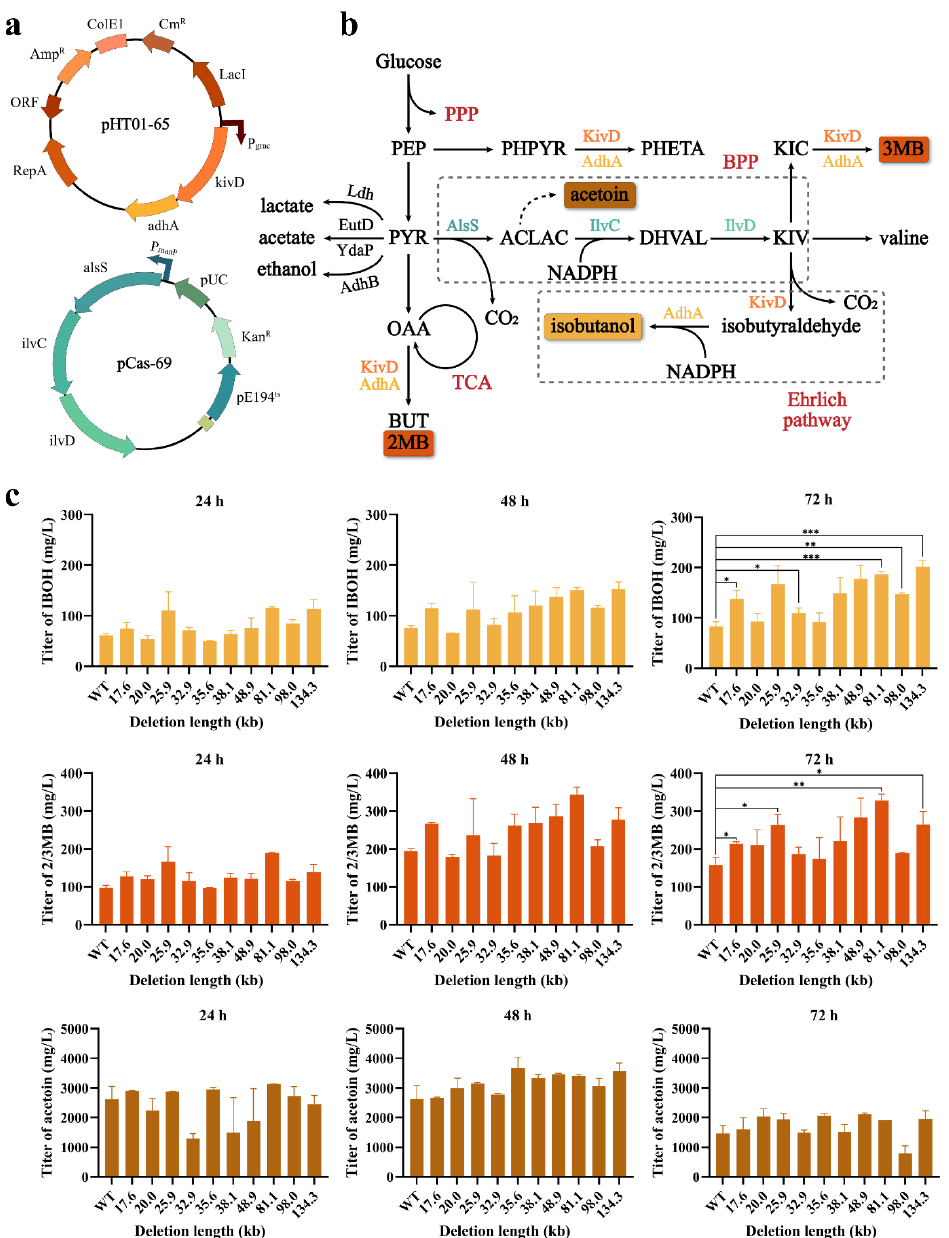
Figure 7. Production pathways for isobutanol and 2/3MB ( a ) The promoter P grac of plasmid pHT01-65 was induced by IPTG to initiate transcription and expression of the kivD and adhA genes. The promoter P manP of plasmid pCas-69 initiates transcription and expression of the alsS , ilvC and ilvD genes upon mannose induction. ( b ) Schematic representation of heterologous pathway leading to isobutanol and 3MB formation in B. subtilis . PEP (phosphoenolpyruvate), PYR (pyruvate), OAA (oxaloacetate), ACLAC (acetolactate), DHVAL (2,3-dihydroxy-3-methyl butanoate), KIV (2-ketoisovalerate), KIC (2-ketoisocaproate), BUT (butanol), IBOH (isobutanol), 2MB (2-methyl-1-butanol), 3MB (3-methyl- 1-butanol), PHPYR (phenylpyruvate), PHETA (2-phenyl ethanol), NADPH (nicotinamide adenine dinucleotide phosphate), PPP (pentose phosphate pathway), TCA (citrate cycle), BPP (biosynthetic 2-ketoisovalerate precursor pathway). ( c ) Results of microaerobic fermentation of wild-type strain GI0 and ten deletion mutants (GI1-3, GI5-8 and GI10-12) at 30 ◦ C for 72 h. Orange represents isobutanol titers produced by 11 strains, red represents titers producing a mixture of 2MB and 3MB, and brown indicates acetoin titers. Values and error bars represent mean and s.d. ( n = 3), respectively. * p < 0.1, ** p < 0.01, *** p < 0.001 as determined by a two-tailed t